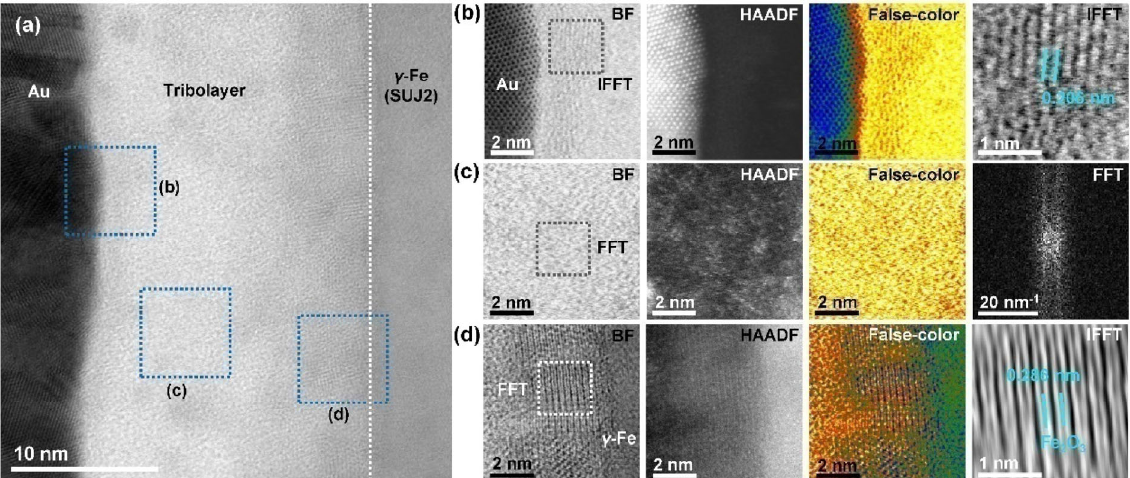
Fig. 2 (a) BF-STEM image showing a tribolayer with thickness of ~20 nm in situ grown on the ball surface for self-mated a-C:H:Si (9.3 at% Si) films after superlubricity test in dry N 2 , and (b − d) its nanostructure revealed by BF-, HAADF-, false-colored BF-STEM and IFFT (or FFT) images. Reproduced with permission from Ref. [9]. © Springer Nature,